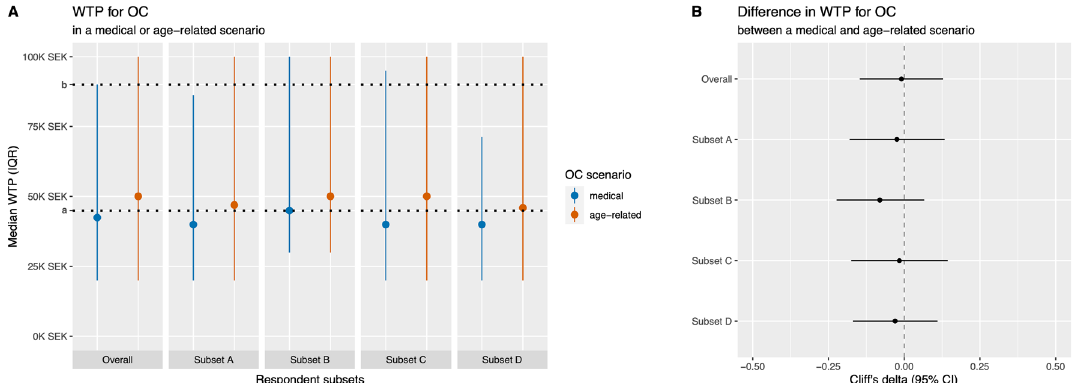
Figure 2. Willingness-to-pay (WTP) for oocyte cryopreservation (OC) in a medical or age-related fertility preservation scenario. Both plots display values obtained from the overall population and from subsets excluding respondents (Subset A) with lower knowledge about OC, (Subset B) not open to consider OC, (Subset C) uncertain about the given WTP, or (Subset D) providing outlier WTP values. ( A ) Comparison of median WTP, in thousand Swedish krona, in the two scenarios. The dotted lines represent the approximate market price for one (a = 45 K) or two (b = 90 K) elective OC procedures in Sweden. ( B ) Cliff’s delta values representing the difference between the probability that a randomly chosen WTP in the medical scenario is higher than one in the age-related scenario, and the probability of the